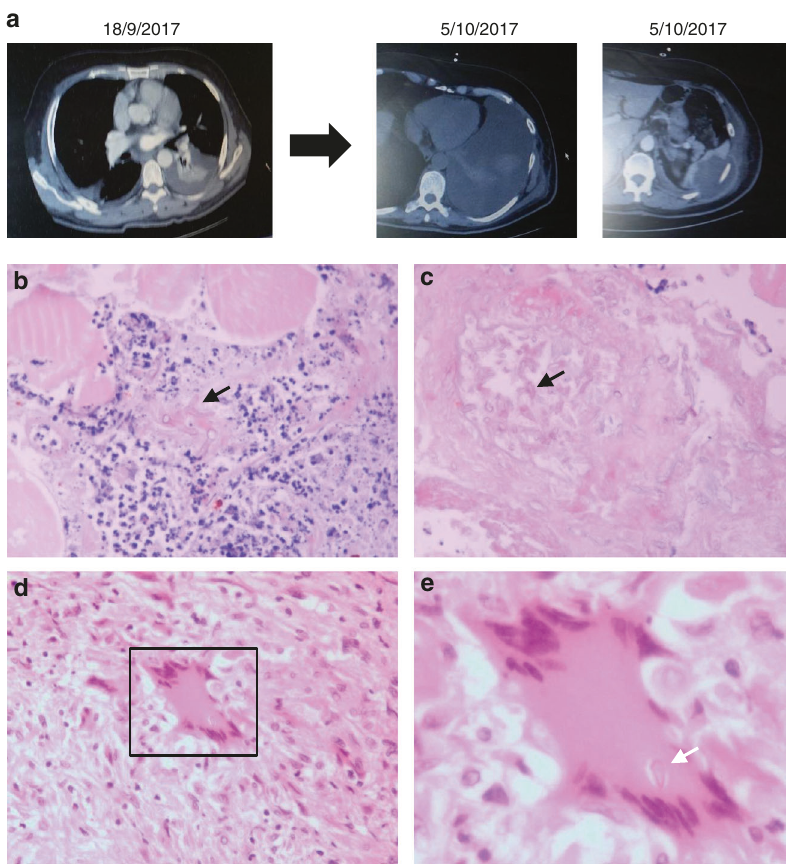
Fig. 9 Invasive pulmonary mucormycosis in a patient with intracellular persistence ( a ). A 60-year-old white male with relapsed acute